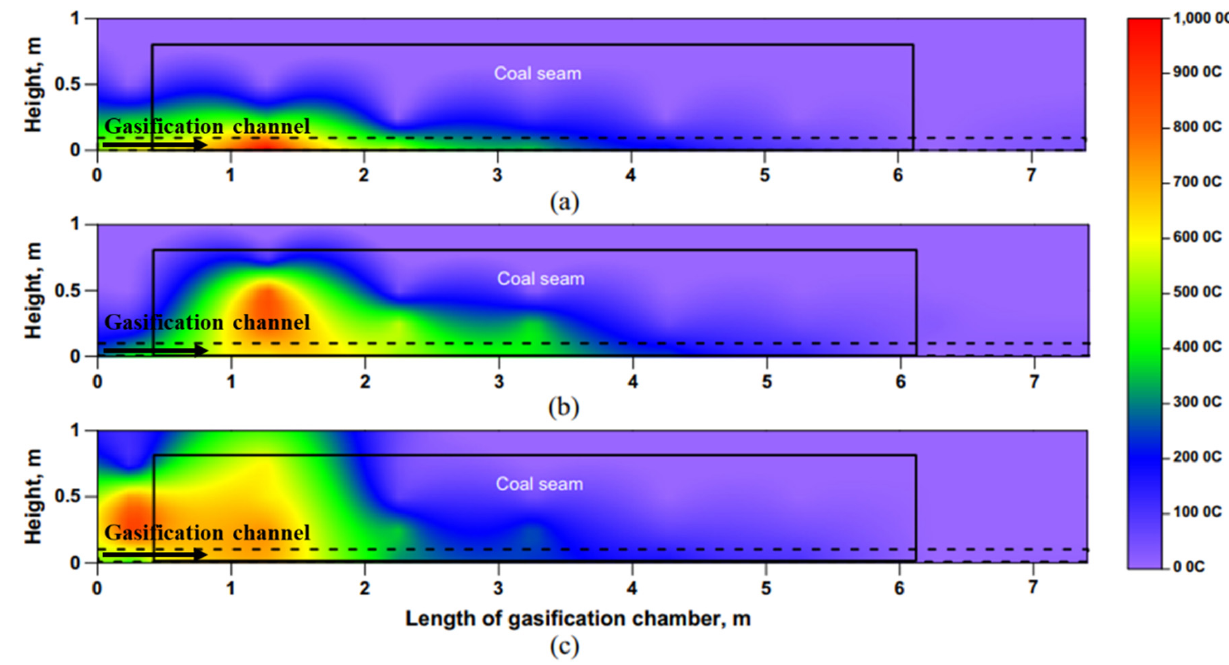
Figure 12. Temperature distribution in the UCG device ( a ) 20 h ( b ) 70 h ( c ) 110 h (from [34]).